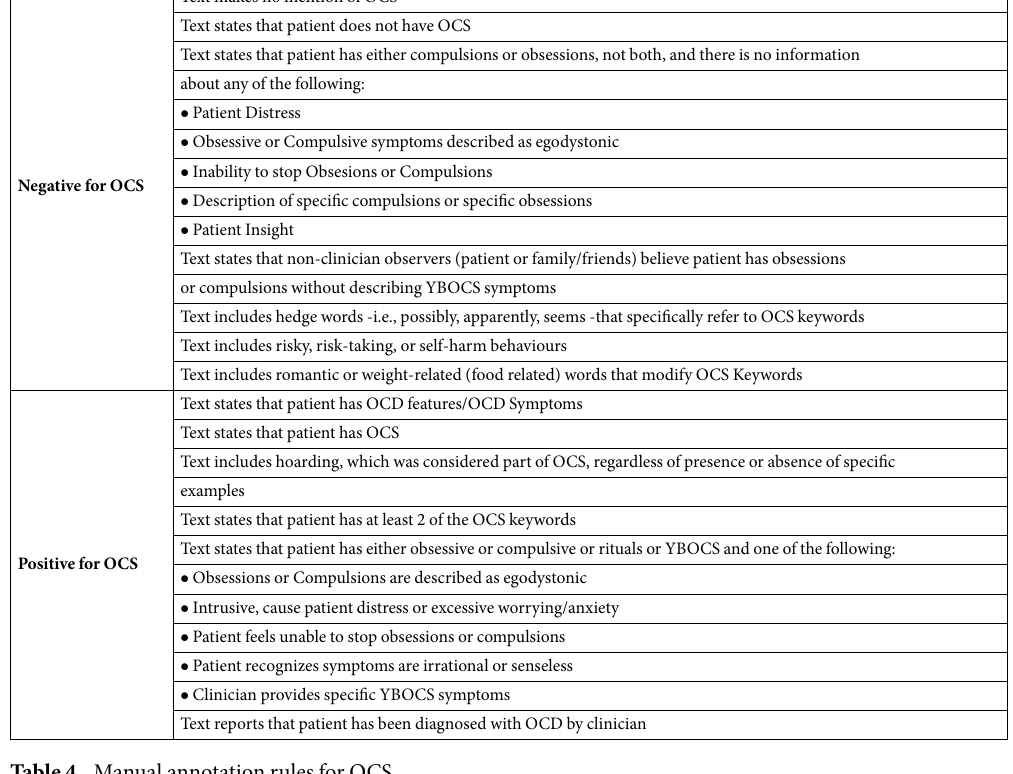
Table 4. Manual annotation rules for